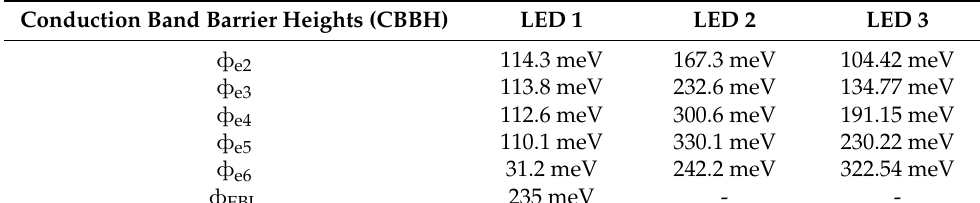
Table 1. Effective conduction band barrier heights (CBBH) of QBs ( ф en ) and EBL ( ф EBL ) for LED 1, LED 2, and LED 3.